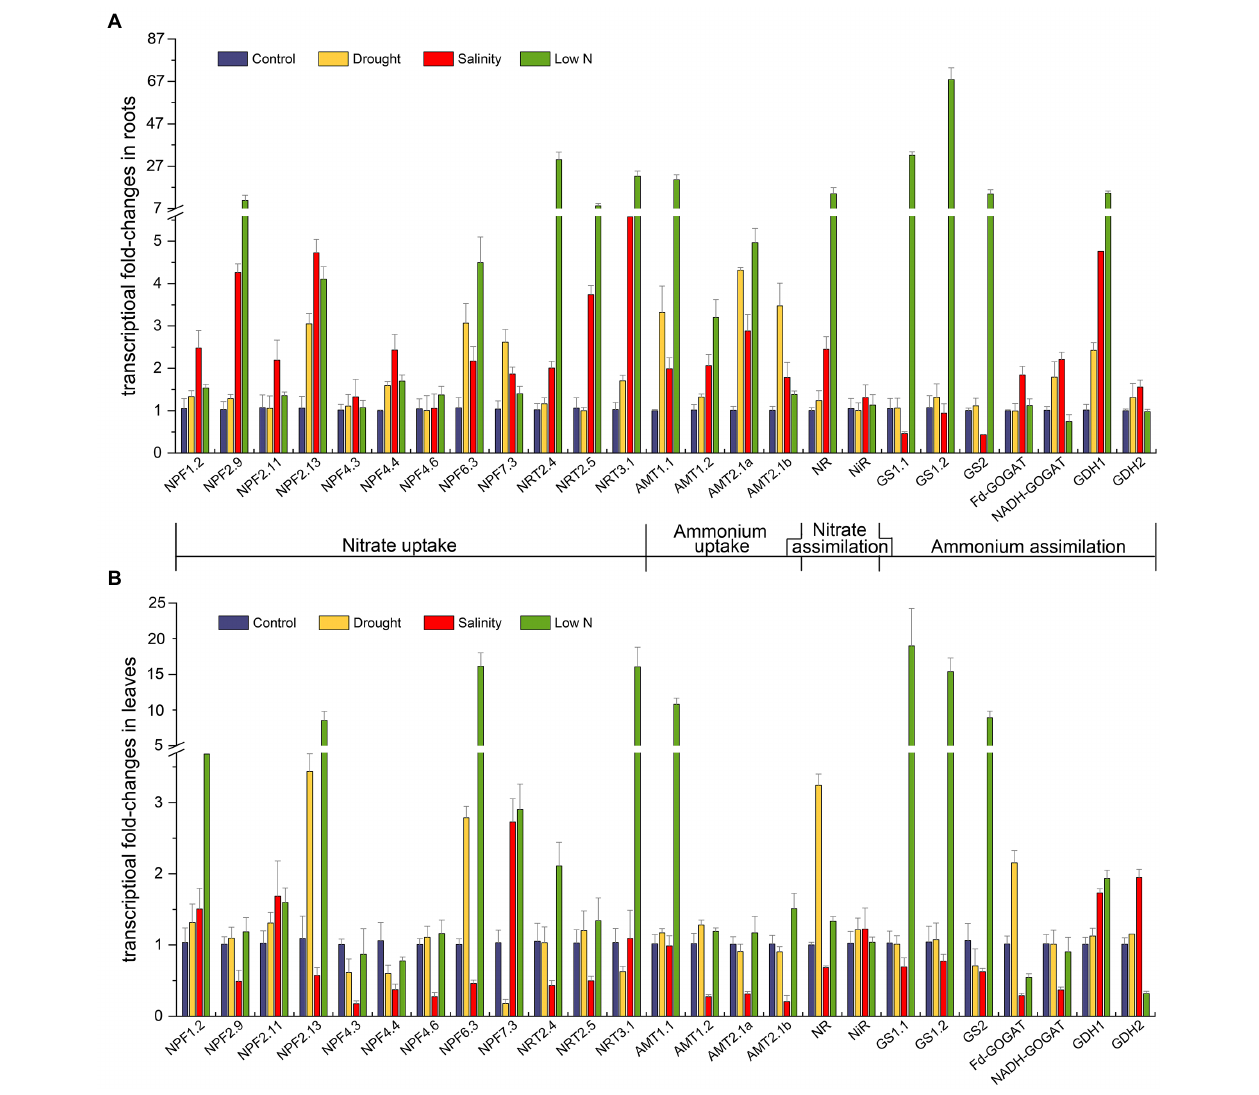
FIGURE 6 | Transcriptional fold-changes of genes involved in N uptake and assimilation in roots (A) and leaves (B) of S. japonica as affected by drought, salinity, and low N treatment. Data indicate means ± SE of three replicates (12 plants). Bars labeled with different letters indicate significant differences between treatments ( p < 0.05). NPF , nitrate transporter 1( NRT1 ); NRT2 , nitrate transporter 2; NRT3 , nitrate transporter 3; AMT1 , ammonium transporter 1; AMT2 , ammonium transporter 2; NR , nitrate reductase; NiR , nitrite reductase; GS , glutamine synthetase; Fd-GOGAT , ferredoxin-dependent glutamate synthase; NADH-GOGAT , NADH-dependent glutamate synthase; and GDH , glutamate